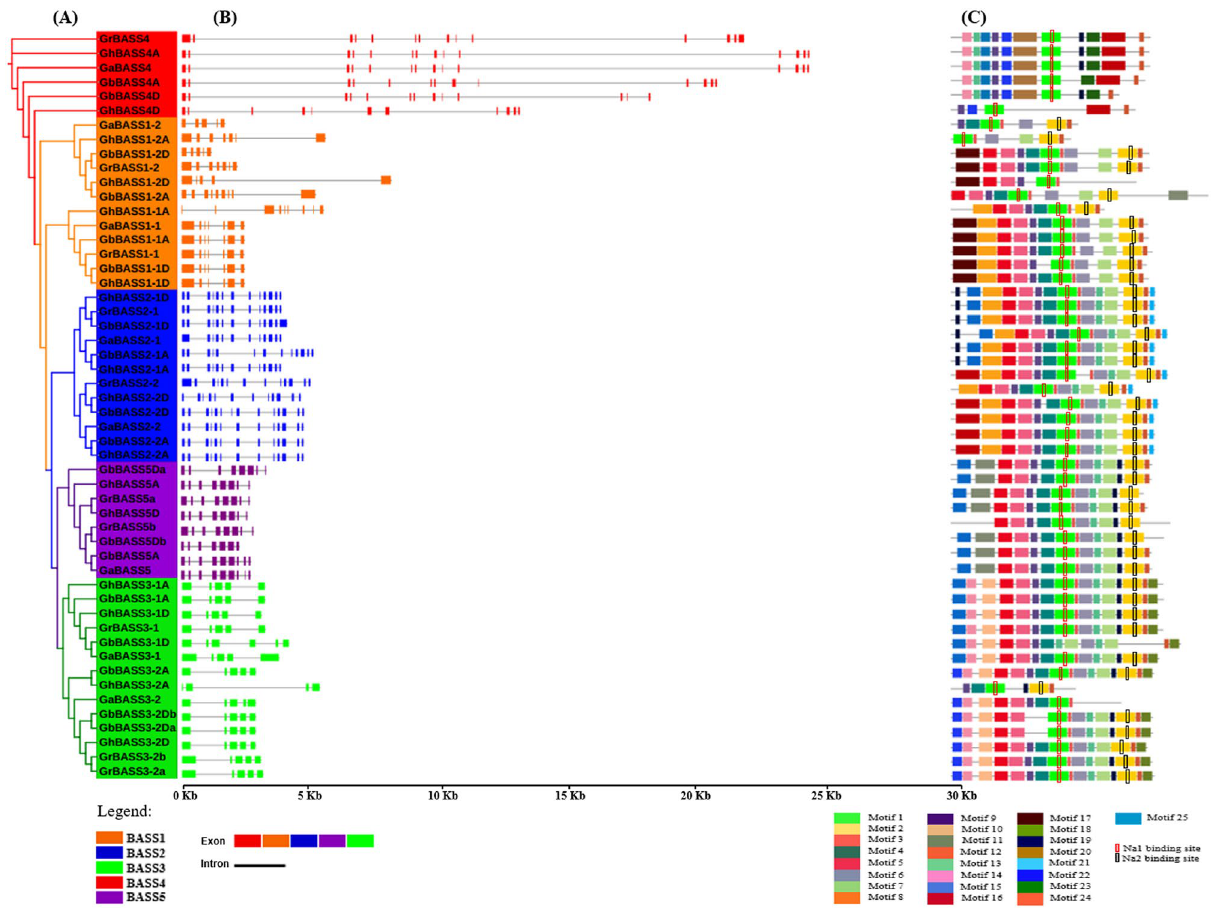
Figure 3. Phylogenetic relationships, gene architectures and conserved motifs of BASS genes from four Gossypium species. ( A ) Phylogenetic tree of putative cotton BASS family genes. The phylogenetic tree was constructed employing the MAFFT, Gblocks, PhyML and iTOL program. ( B ) Exon/intron organization of Gossypium BASS genes. Information for distribution of exons and introns was obtained from gff3 files of cotton genome annotation data, and gene architectures were depicted using the TBtools-JRE1.6 software. The color boxes indicate exons, and the grey lines represent introns. ( C ) Distributions of conserved motifs. Motifs were mined using the MEME software and depicted as 25 different color boxes. Na1 and Na2 binding sites are red and black rectangular boxes,